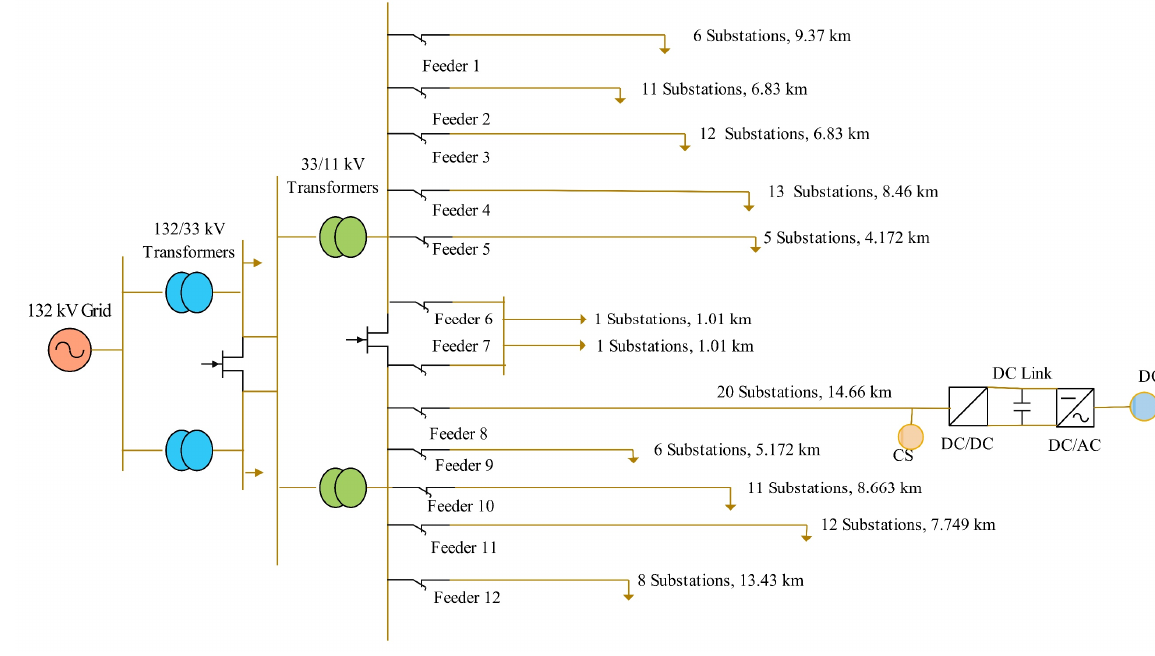
Figure 12. Single-line diagram of the studied network.